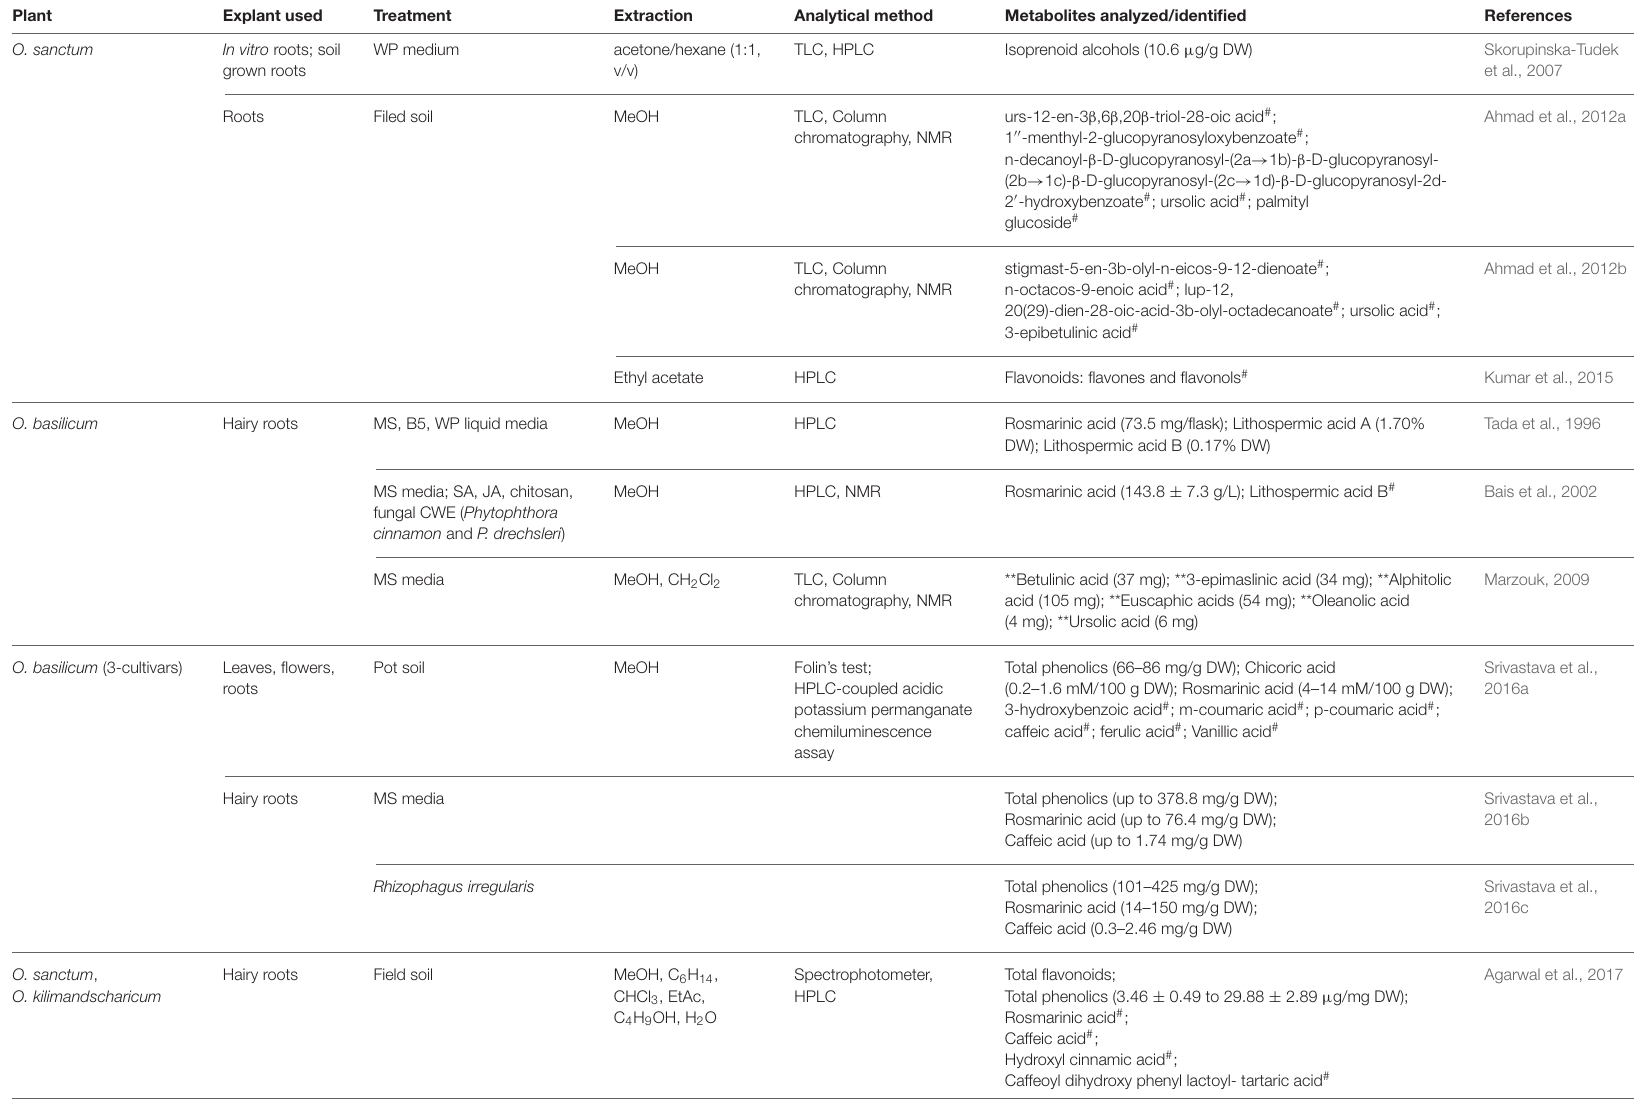
TABLE 3 | Identification of phytochemicals from soil-grown, in vitro , and hairy roots of Ocimum basilicum and Ocimum sanctum .